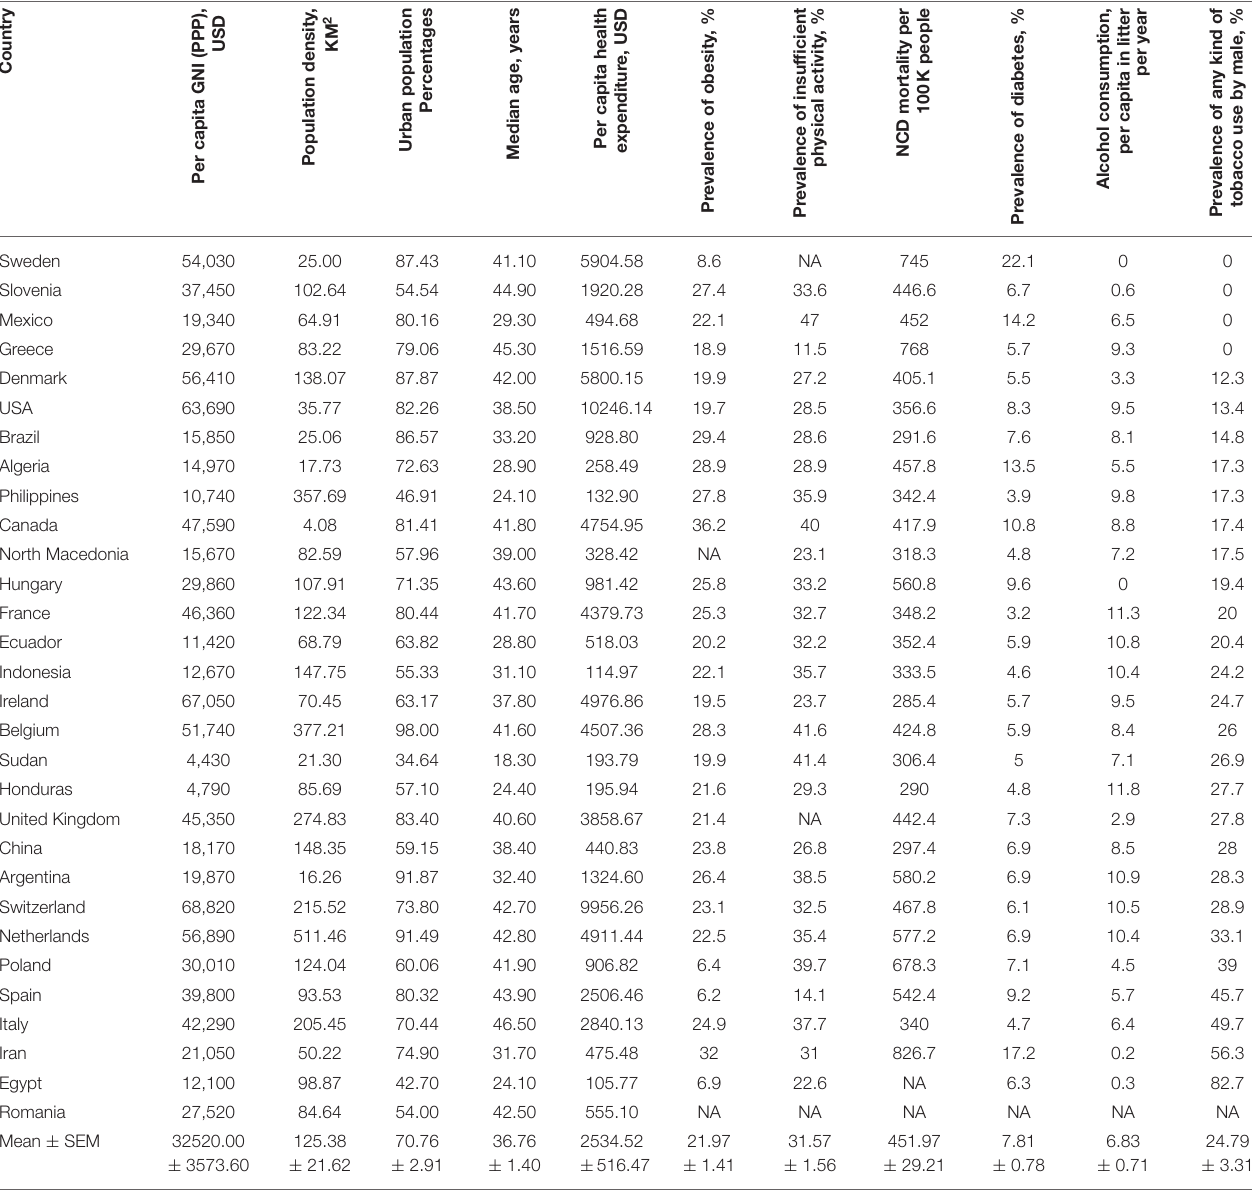
TABLE 3 | Top 30 countries according to case fatality rate with their parametric